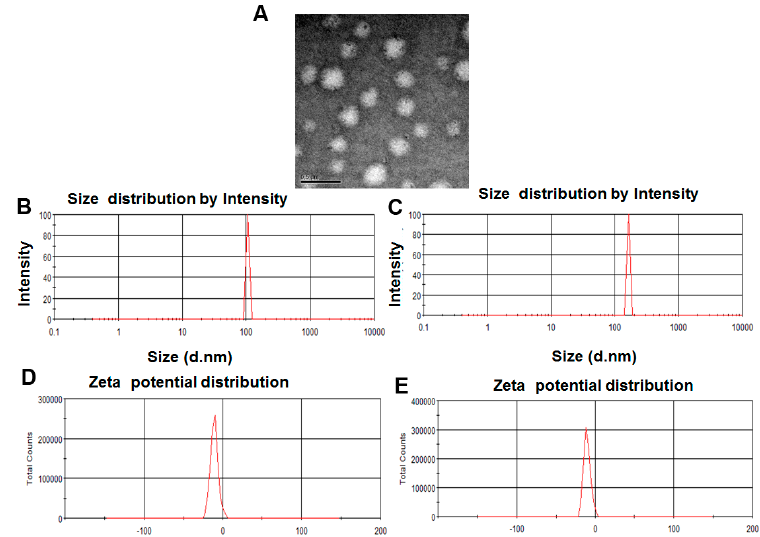
Figure 2. ( A ) Morphology of samples observed by transmission electron microscopy (TEM), Res-SLNs, Scale bar, 500 nm; ( B , C ) The size distribution for SLNs and Res-SLNs; ( D , E ) The zeta potential for SLNs and Res-SLNs.